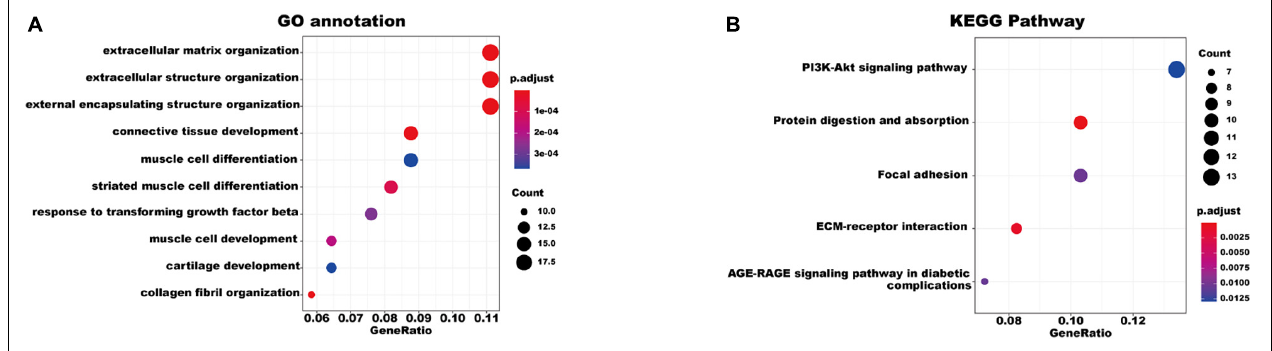
FIGURE 3 | Gene Ontology and KEGG pathway enrichment of the robust DEGs in AF. (A) The enriched GO annotation terms. (B) The enriched KEGG pathway. GO, Gene Ontology; KEGG, Kyoto Encyclopedia of Genes and Genomes; DEG, differentially expressed gene.